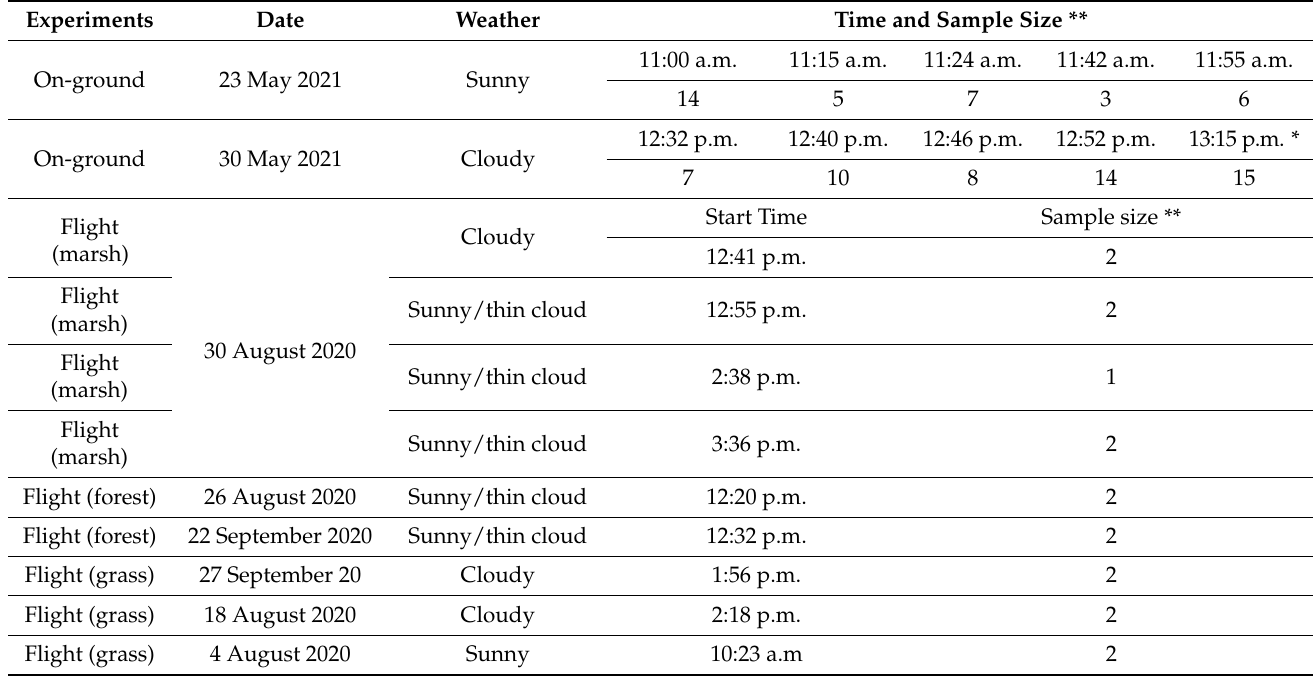
Table 2. The list of experiments and collected samples (calibration images) to extract CRP and DLS irradiance. The three sites for flight missions are marsh, forest, and grass,